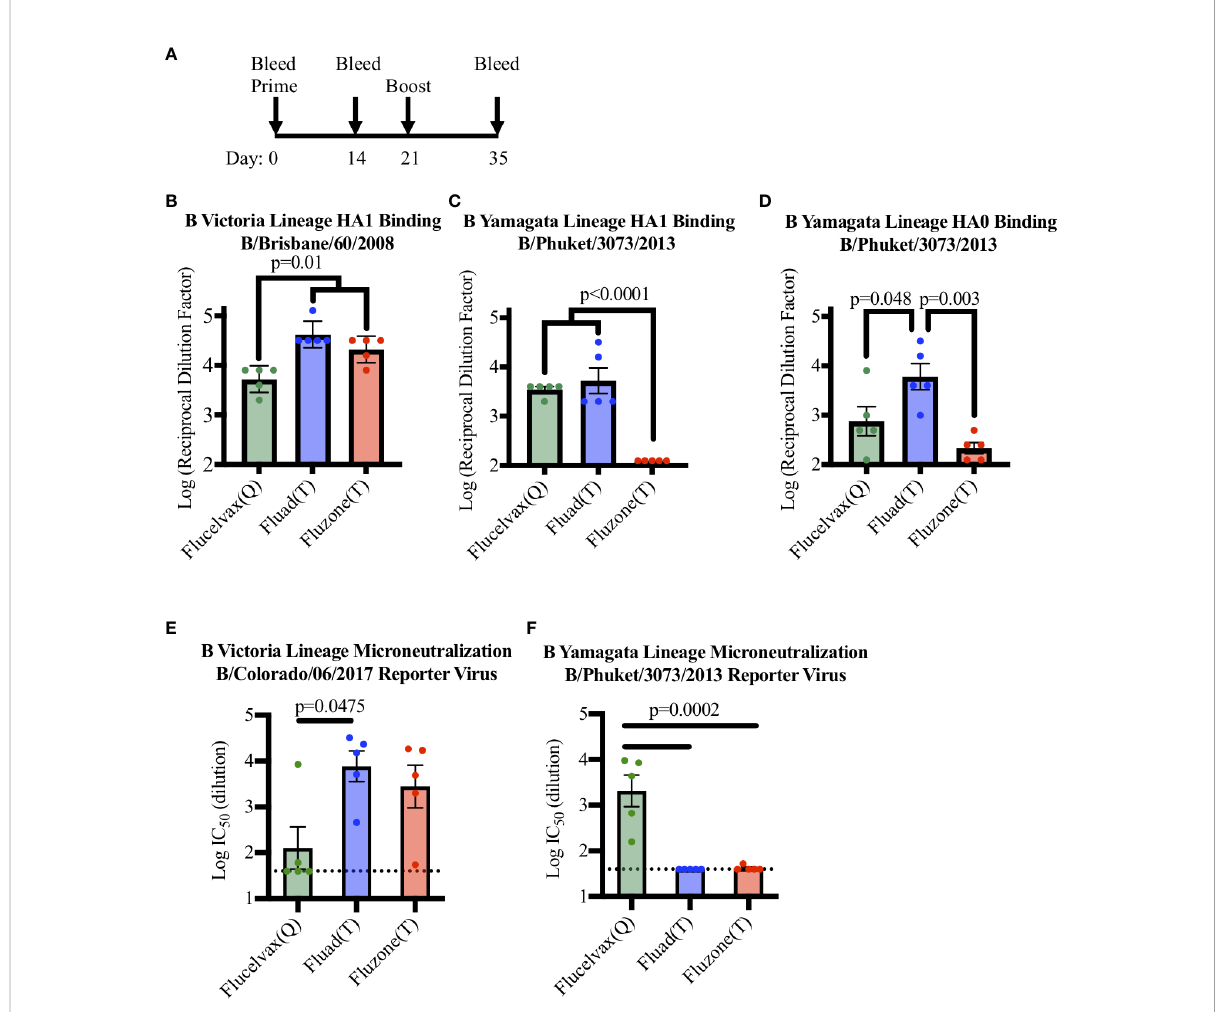
FIGURE 2 Comparing antibody and microneutralization levels of vaccine sera against in fl uenza B Victoria and in fl uenza B Yamagata lineages: (A) Immunization schedule indicating days for the prime and boost for the vaccines (day 0 and 21) and bleeds (day 0, 14, and 35). (B – D) ELISA binding of immunized mouse sera to in fl uenza B virus recombinant HA proteins: (B) HA1 of B-V (B/Brisbane/60/08), (C) HA1 of B-Y (B/Phuket/ 3073/13), (D) HA0 of B-Y (B/Phuket/3073/13), P-values are indicated for the signi fi cance of differences. (E, F) Testing microneutralization activities of vaccine sera using in fl uenza B reporter viruses derived from (E) B-V (B/Colorado/06/2017) and (F) B-Y (B/Phuket/3073/2013). Vaccines were Flucelvax (Q) (green), Fluad (T) (blue) and Fluzone (T) (red). The dotted horizontal lines in panels E and F indicates the threshold for detection above background in the